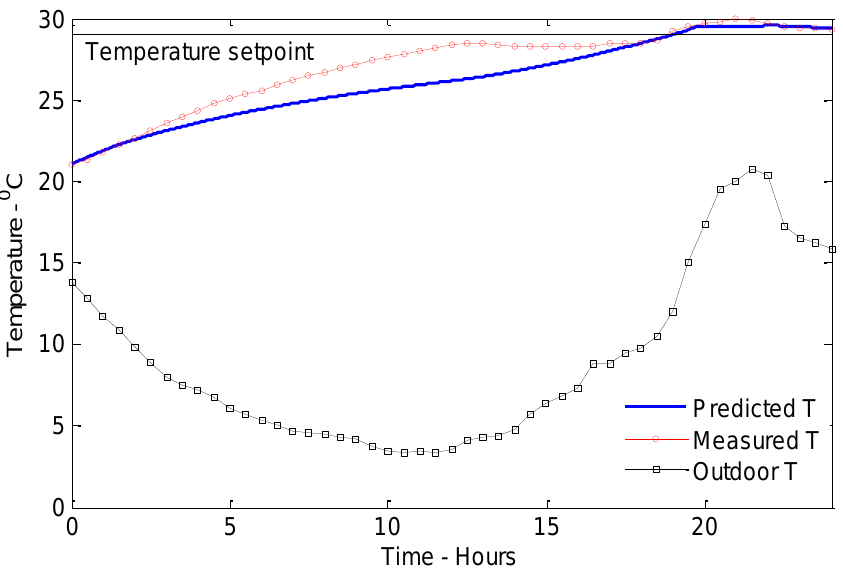
Figure 7. Variation of the internal and external air temperatures for Case